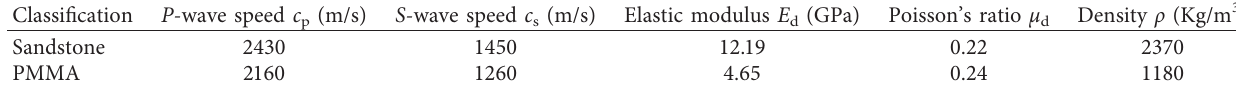
Table 1: Dynamic parameters of PMMA and sandstone.